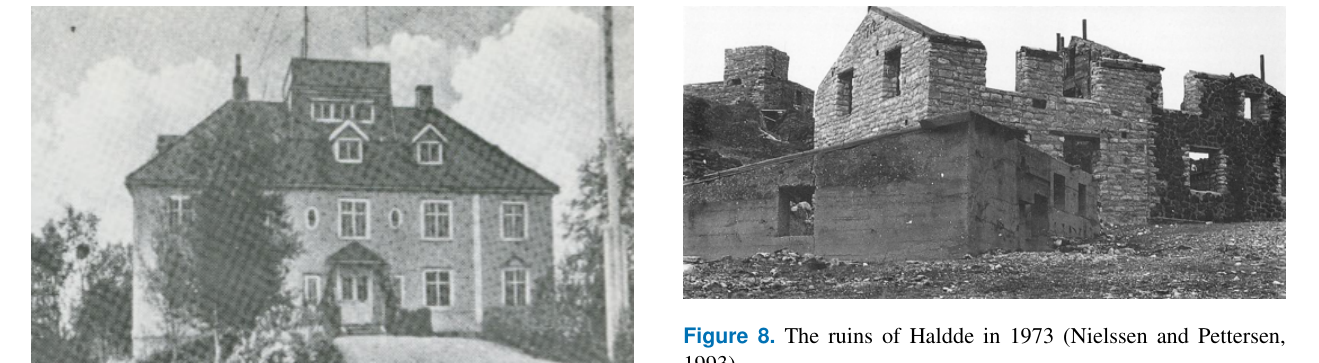
Figure 8. The ruins of Haldde in 1973 (Nielssen and Pettersen,